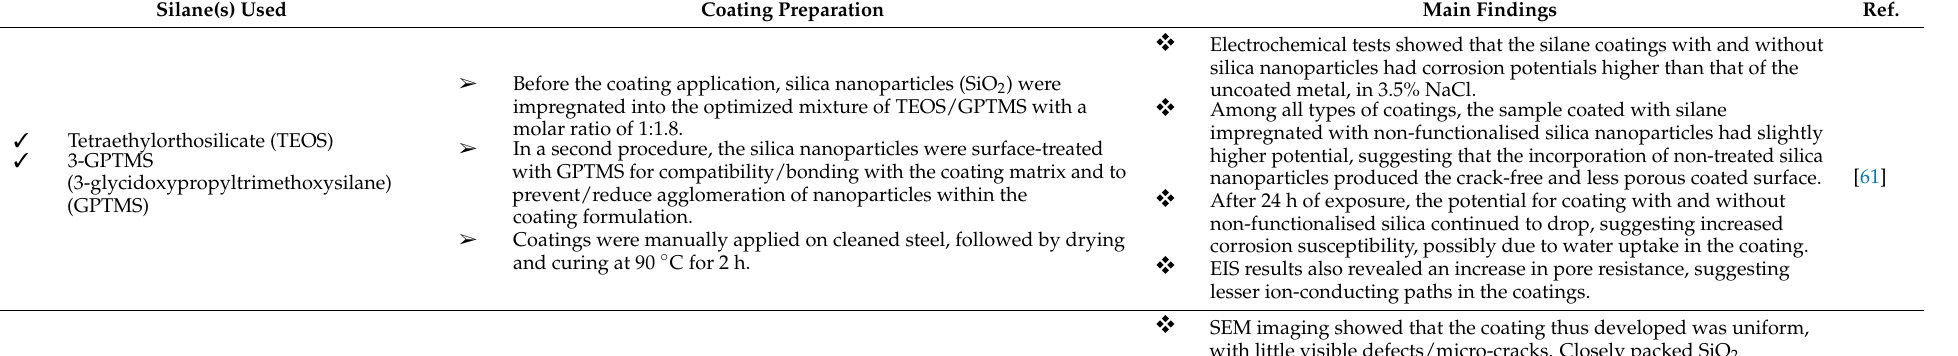
Table 1. Different approaches for improving silane coatings and the main findings, as reported in the literature.